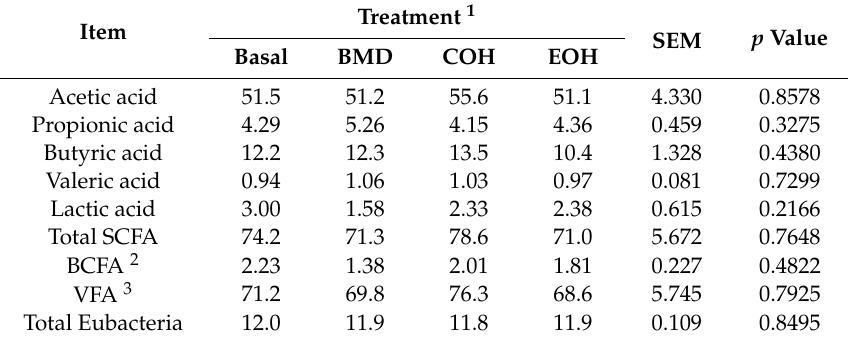
Table 5. E ff ect of dietary supplementation with coarse or extruded oat hulls on cecal short chain fatty acids (SCFA) composition (mmol / kg) and total Eubacteria (16S rDNA copies / gram of sample) in broiler chickens.